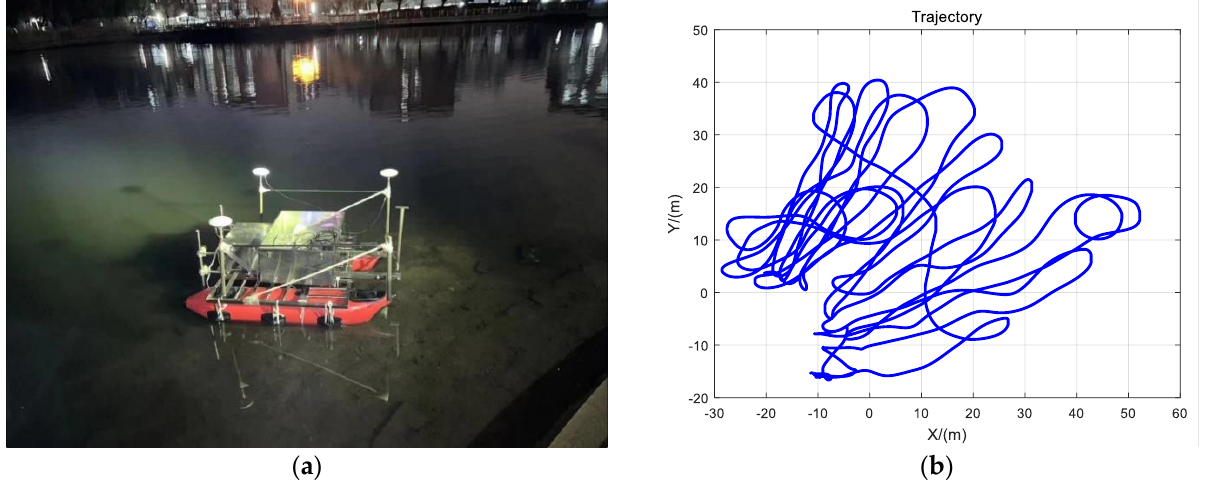
Figure 10. ( a ) Unmanned ship carrier platform for testing; ( b ) the trajectory of the unmanned ship.